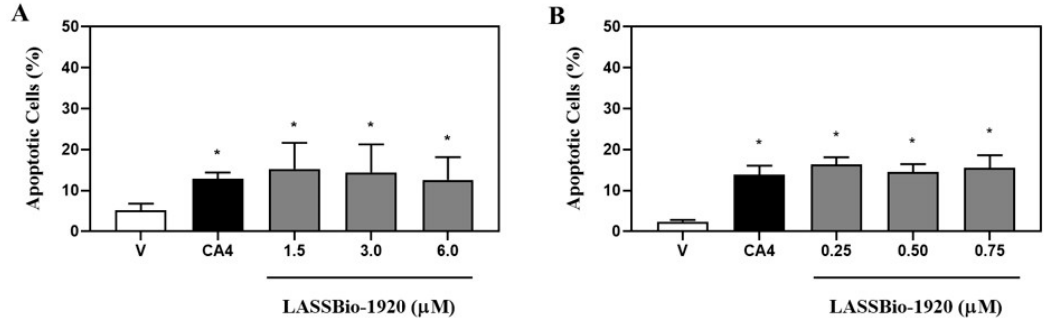
Figure 4. Apoptosis induction analysis of HCT-116 ( A ) and PC-9 ( B ) human tumor cells treated with LASSBio-1920 (1.5, 3.0 and 6.0 µ M against HCT-116; and 0.25, 0.5 and 0.75 µ M against PC-9) LASSBio-1920 (1.5, 3.0 and 6.0 μ M against HCT-116; and 0.25, 0.5 and 0.75 μ M against PC-9) after 48 h of incubation. Control group received the same amount of vehicle whose concentration was